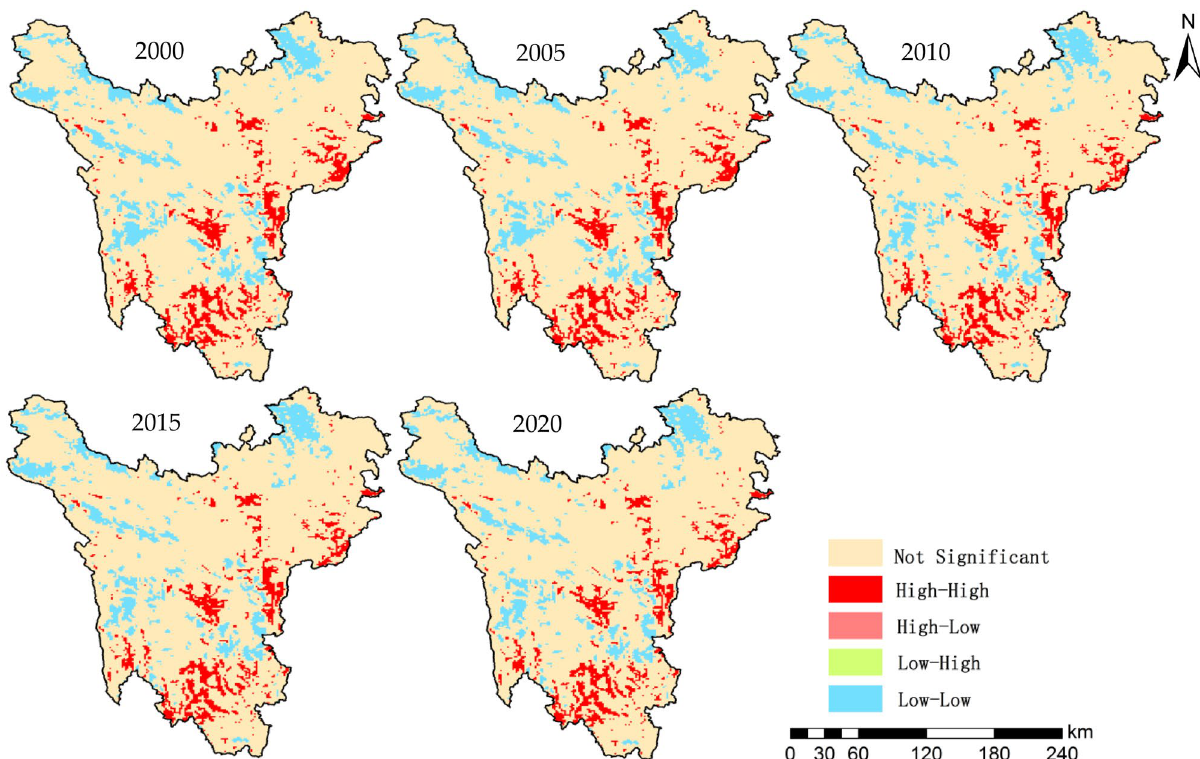
Figure 4. LISA cluster map of carbon storage in the Western Sichuan Plateau on a grid scale. Map generated with ArcGIS 10.2 (ESRI).